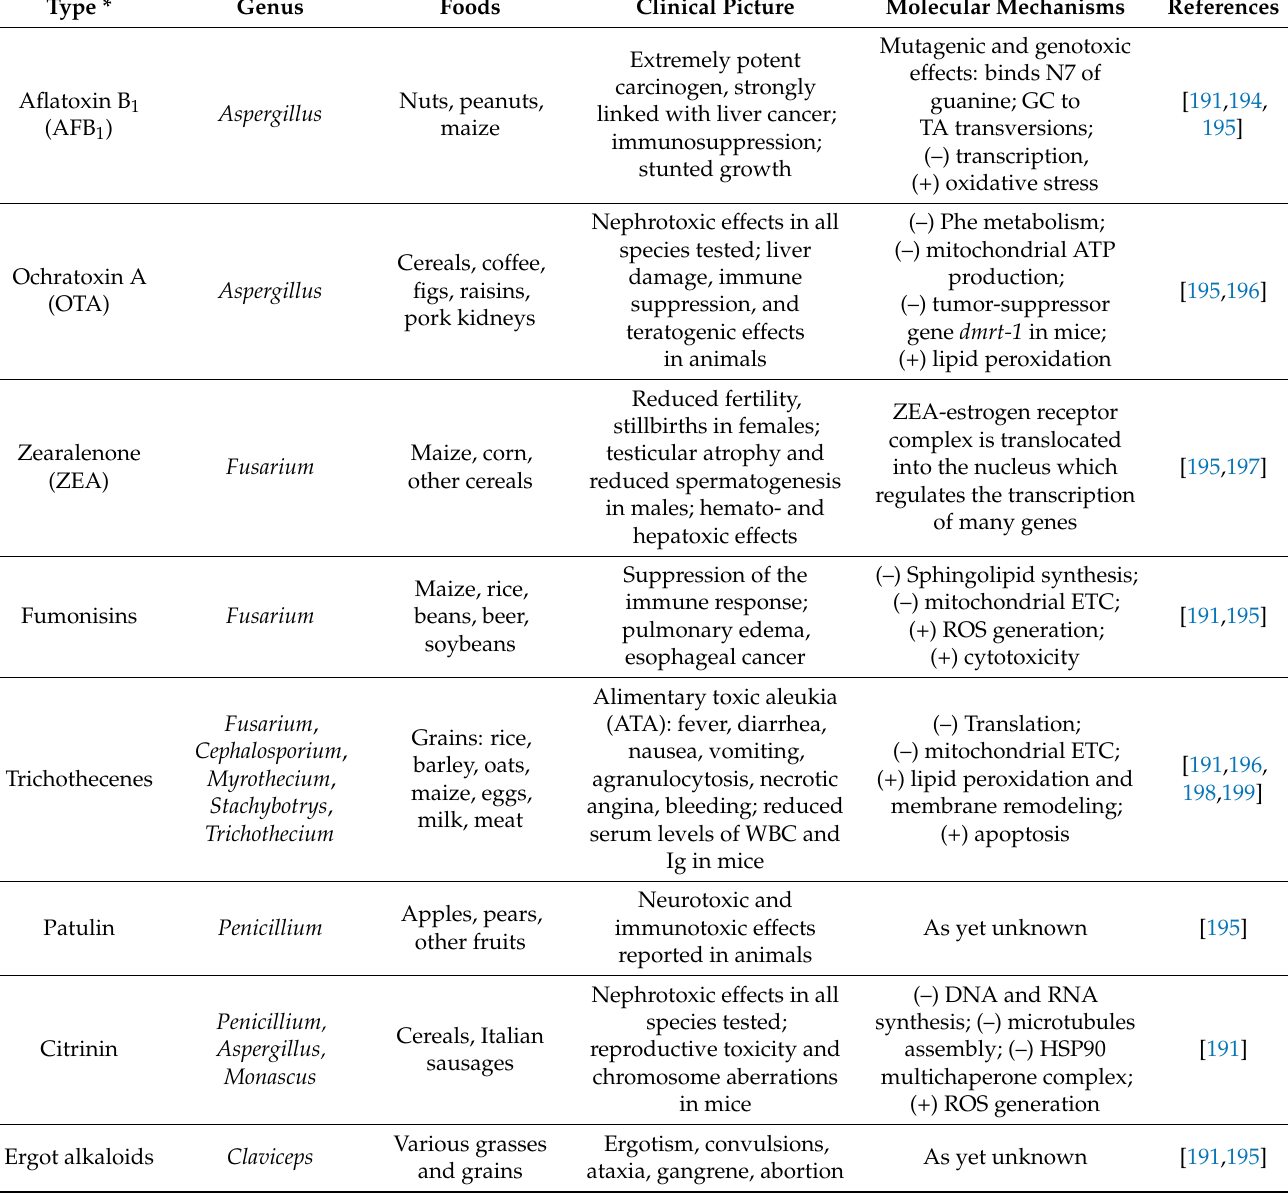
Table 5. Most harmful mycotoxins that often contaminate human